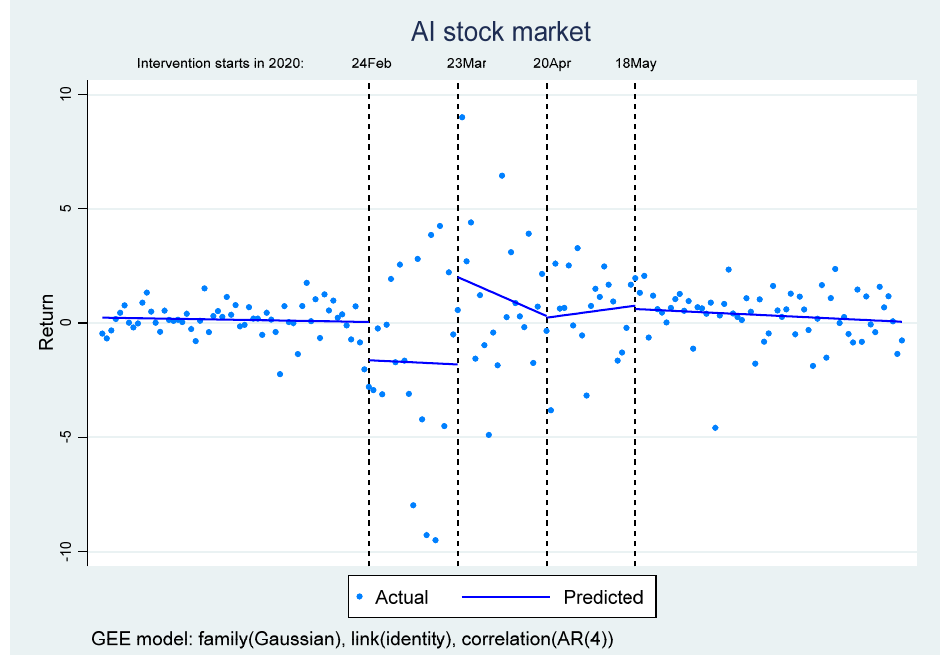
Figure 3. Multiple impacts of COVID-19 on the artificial intelligence stock market. Source: Authors’ illustration. Note: The multiple impacts of the COVID-19 interventions t 1 (24 February 2020), t 2 (23